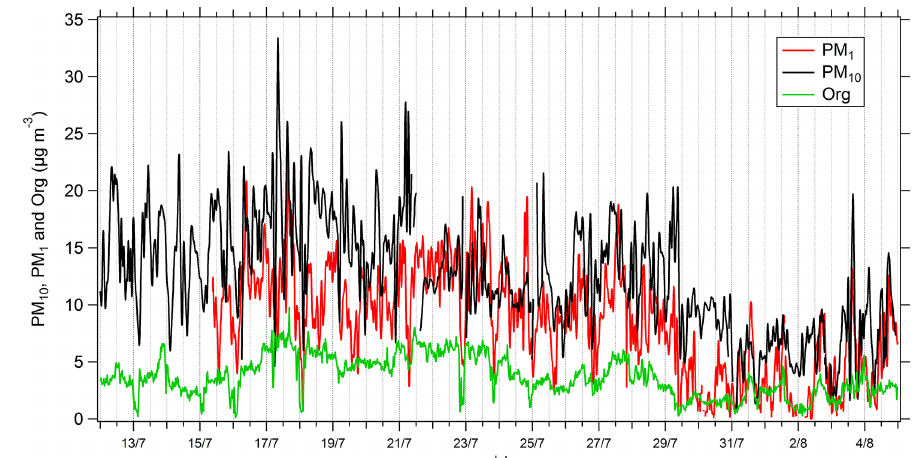
Figure 2. Time series of mass concentrations of PM 10 (black line), PM 1 (red line) and organic fraction in NR-PM 1 (green line).